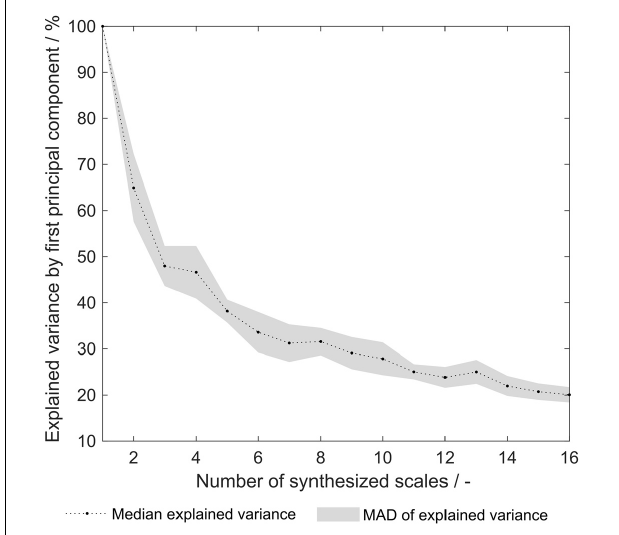
FIGURE 8 | Explained variance by first principal component of synthesized hydrophobicity scale tables. For each number of synthesized scales, corresponding to the number of training subsets that were generated for scale synthesis, the median of 20 repetitions is shown. The shaded area represents the median absolute deviation (MAD).